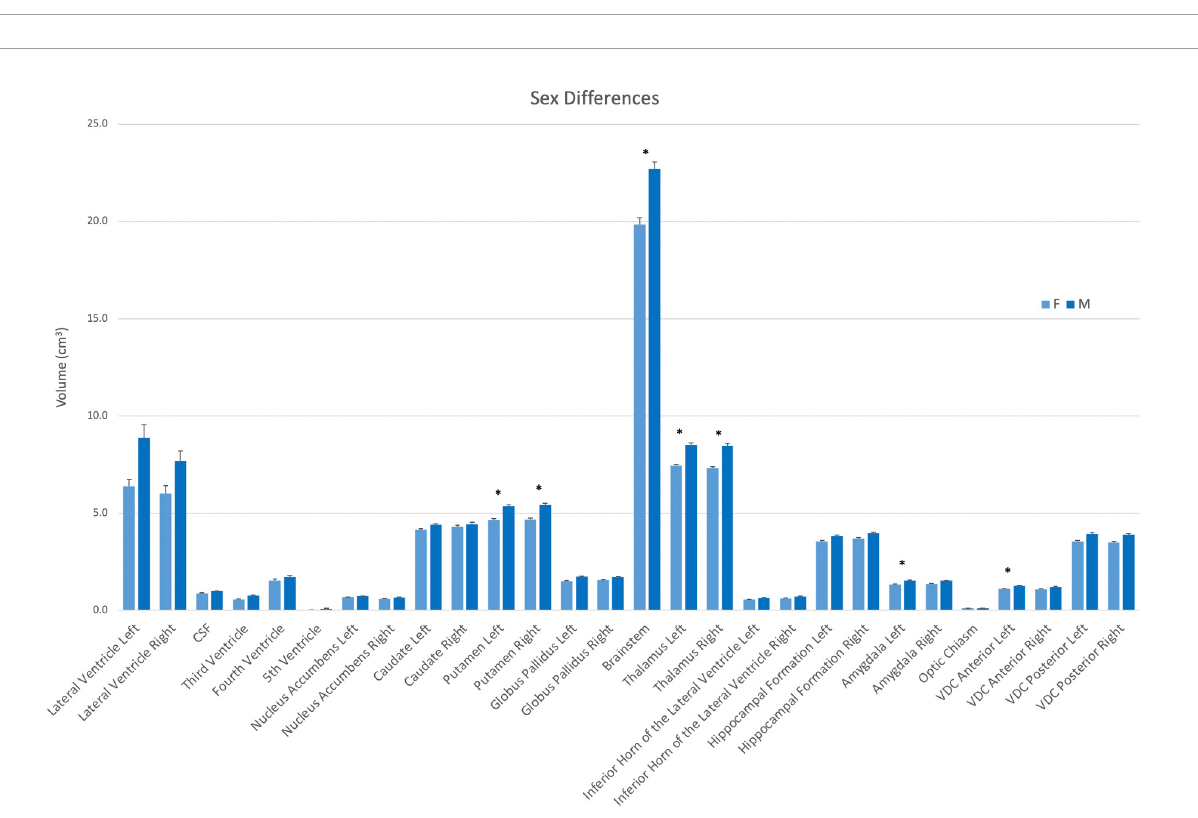
FIGURE5 Volumes of each structure in the present dataset ( n = 50) according to sex (female–light blue; male–dark blue). Asterisks signify a significant difference ( p < 0.01), with multiple comparisons controlled for by Bonferroni post-hoc comparisons. Error bars represent the standard error of the mean. Abbreviations: CSF, cerebrospinal fluid space in the transverse cerebral fissure (TCF); ILV, inferior horn of the lateral ventricle; VDC, ventral